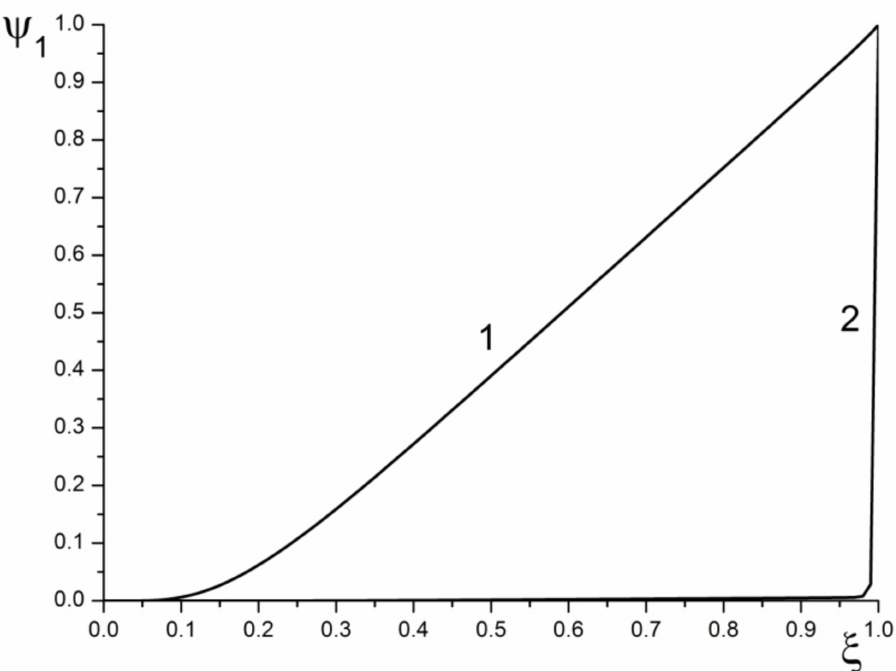
Figure 7. The integral Ψ 1 ( ξ ) . Approximate model (29). A = 2.75 × 10 − 18 ; h s = 7.14 × 10 2 ; µ = 75.0; g = 1.22 × 10 − 20 . 1—monotonic critical curve. Ar = 0.02; Pe = 50.0; θ s = 702.01. 2—non-monotonic critical curve. Ar = 0.012; Pe = 50.0; θ s = 87.70.